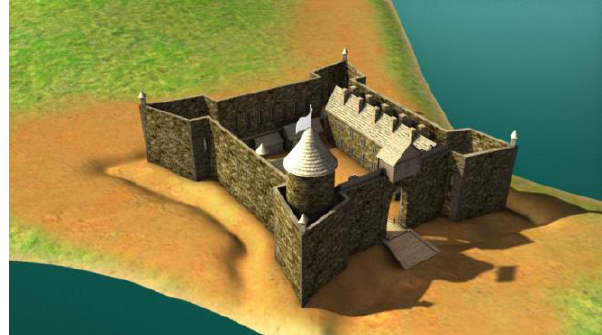
Figure 6: The wireframe model of the 1688 fortress. Geographic landscapes were created in Maya by means of tracing curves over the outline of the plans for 1685 3 which were provided by the City of Kingston. The outline became a planar surface and that surface was converted into a polygon surface with numerous quarter geometries. As the ensuing landscapes for 1673, 1675, 1680, 1685, and 1688, were created, the geometric maps were shot by the UV Snapshot included in the UV texture editor in Maya and were imported into Photoshop to create color geographic topography. A displacement map and a normal map were created in Crazybumps and were then imported back into Maya to be placed onto a bump map for the landscapes. Moreover, the sea was created by means of using an Ocean Shader and Ocean, and minor corrections were required until the color was very similar to the color of the sea around Kingston that was dully emerald or bluish in color. Three lights were also set up: Key Light, Fill Light, and Back Light. The key light was like sunlight set as a directional light, turned towards the north, and its color was slightly bright yellowish. The Fill Light was a secondary light set as a spot light facing southwestward, and its color was slightly bluish. The Back Light was the third light set as an additional spot light in a southern direction, and its color was dimly warm orange. Originally, the fort’s gate was turned northeast so that the 3 Fort Frontenac Based on A 1685 Map. Map. Scale 1:1000. Kingston, Ontario: City of Kingston, 2006.